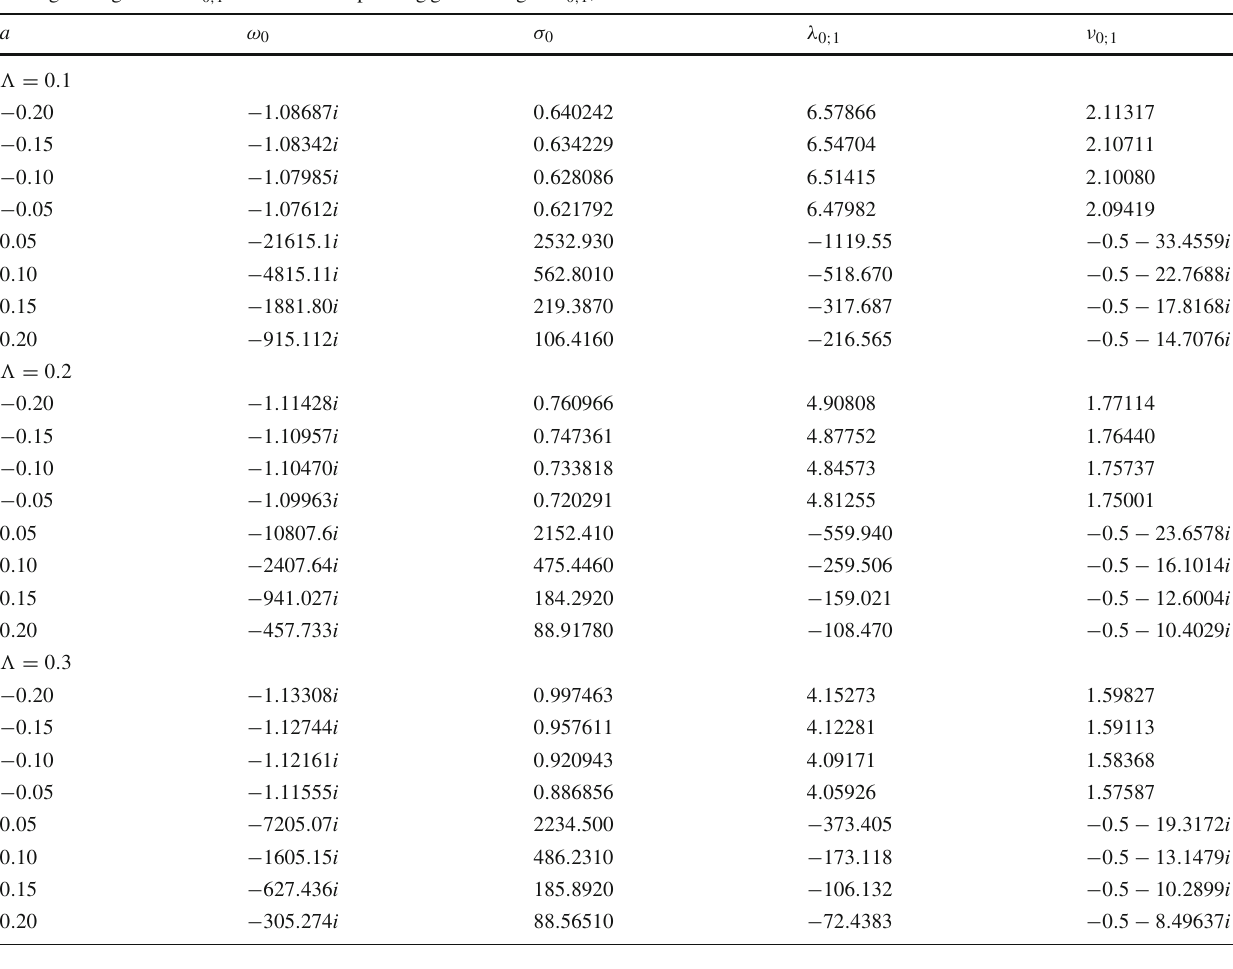
Table 1 (dS) Cases 1 and 2. Massless scalar fundamental QBSs ω n and their corresponding values of the real part of σ n = A ω n − 1 − n , and theangulareigenvalue λ 0 ; 1 andtheircorresponding generaldegree ν 0 ; 1 ,